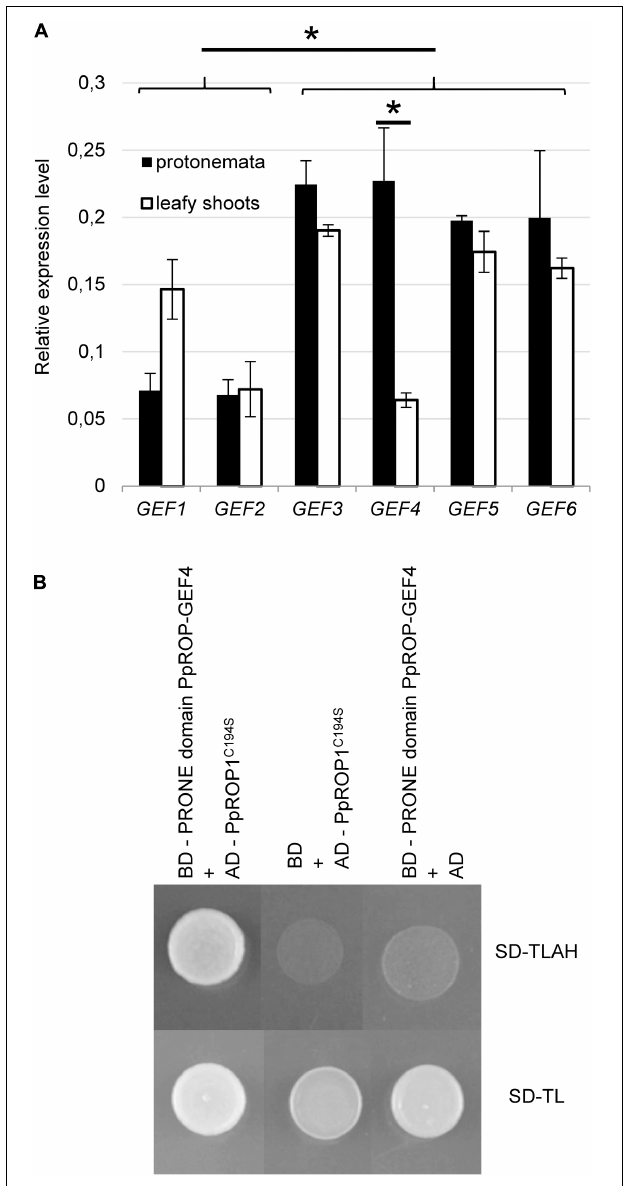
FIGURE 1 | PpROP-GEF4 is preferentially expressed in protonemata and interacts with PpROP1 in yeast two-hybrid assays. (A) Comparative analysis by quantitative PCR (qPCR) of transcript levels of all 6 P. patens PpROP-GEF genes ( PpROP-GEF1-6 ; indicated as GEF1 - GEF6 ) in protonemata and leafy shoots. Relative expression levels are indicated, which represent absolute PpROP-GEF transcript levels normalized relative to the absolute transcript level of the reference gene PpACTIN5 . The statistical significance of differences between all data sets was assessed using ANOVA (Bonferroni-Holm, one factor). ∗ P < 0.05: statistically significant differences relevant in the context of this study (stronger expression of